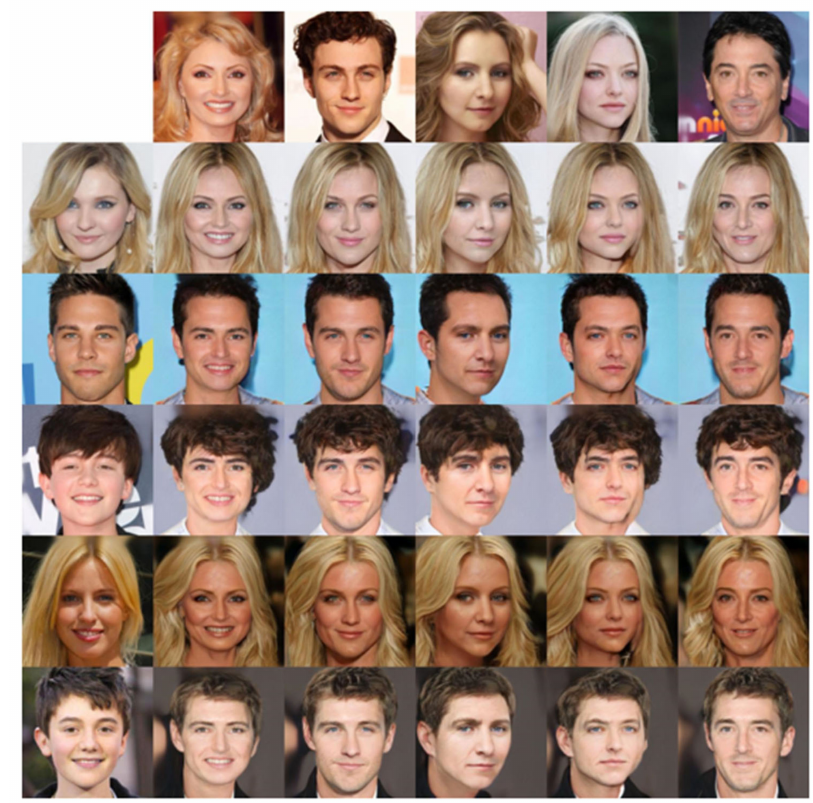
Figure 10. Reference guided image synthesis in CelebA-HQ (The first column is the original image; the first row is the reference